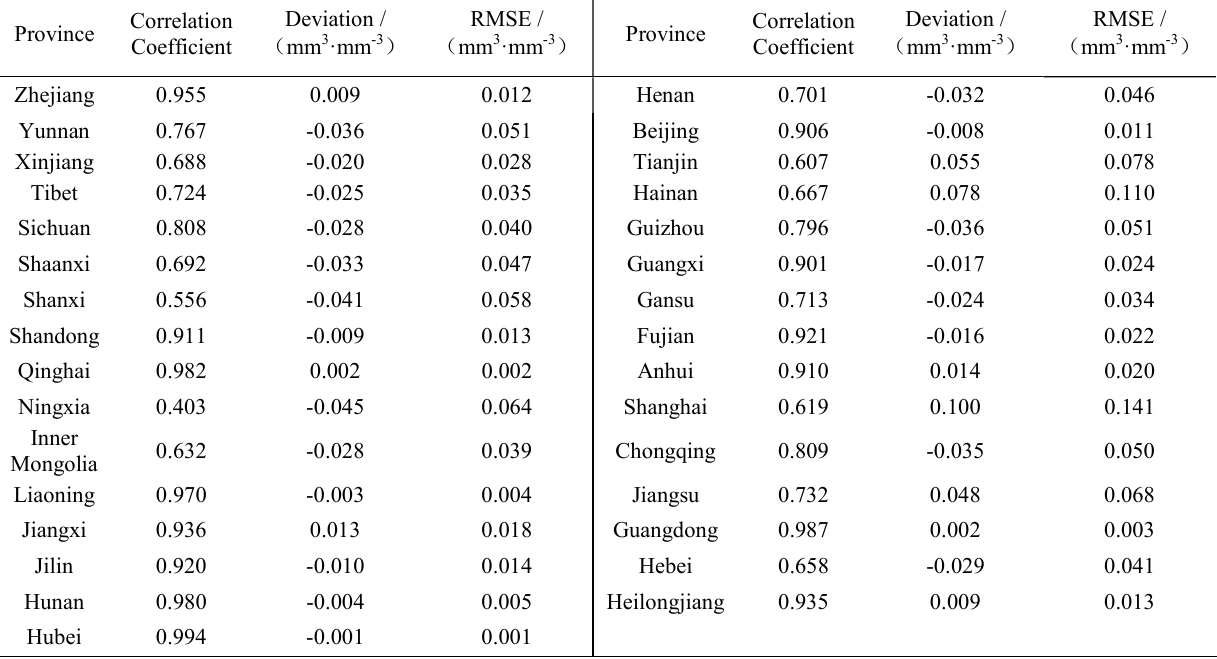
Table 1 Soil Moisture Simulation Results on 2016 were evaluated by